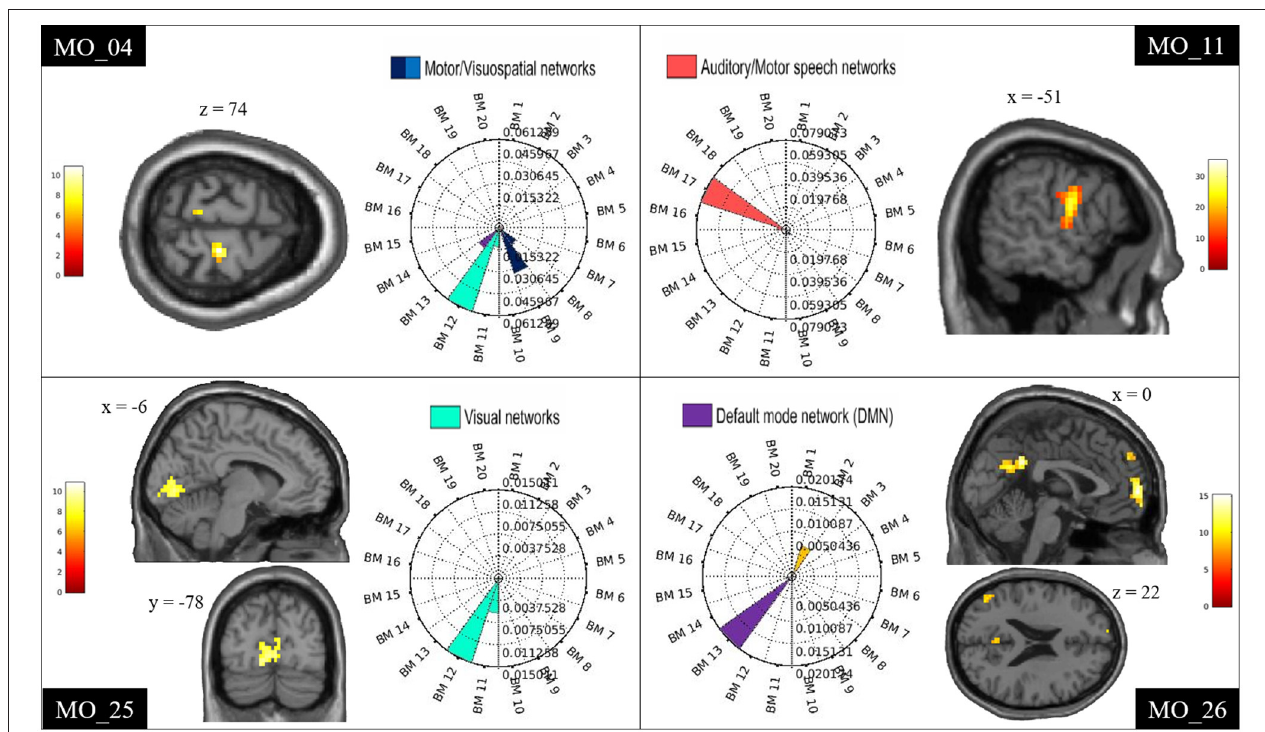
FIGURE 2 | Examples of ICN alterations. Examples of single-subject results showing spike-triggered BOLD signal changes within the motor (MO_04), auditory/motor speech (MO_11), visual (MO_25), and DMN (MO_26). Clusters are shown in sagittal, coronal, and axial slices of an anatomical template as implemented in spm12. The rose plots represent the ICN_Atlas output: the spatial involvement metric expressing the ratio between the number of activated voxels and the volume of the ICNsi. BM refers to the co-activation networks of the BRAINMAP20 atlas base